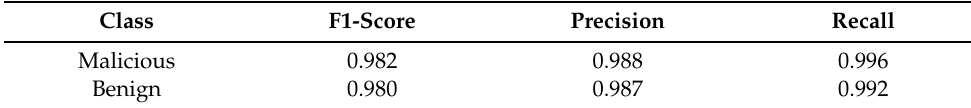
Table 4. KTSDroid performance for malicious and benign classes.